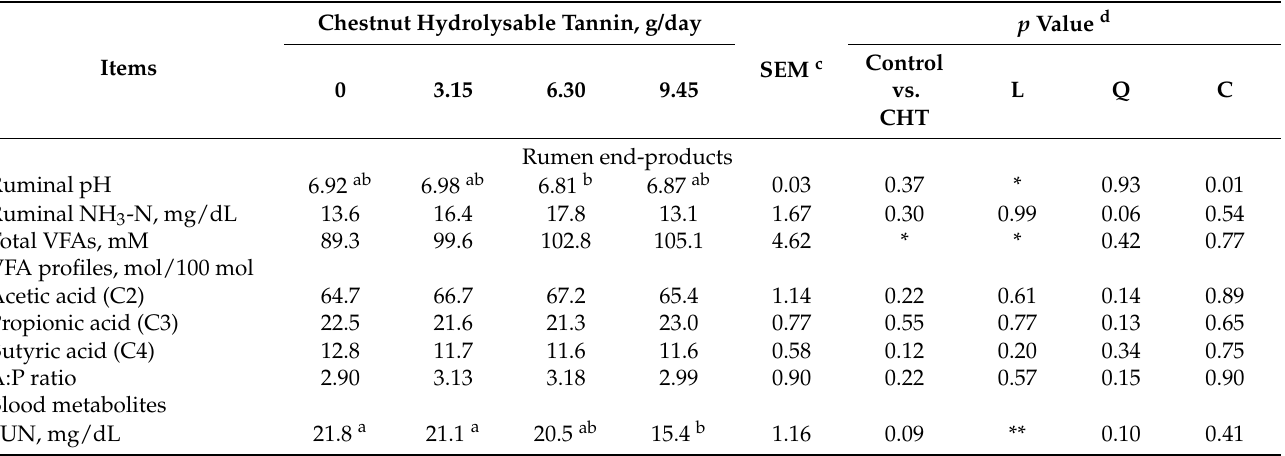
Table 3. Ruminal pH, NH 3 -N, volatile fatty acids (VFAs) and SUN in lactating dairy cows supple- mented with various levels of chestnut hydrolysable